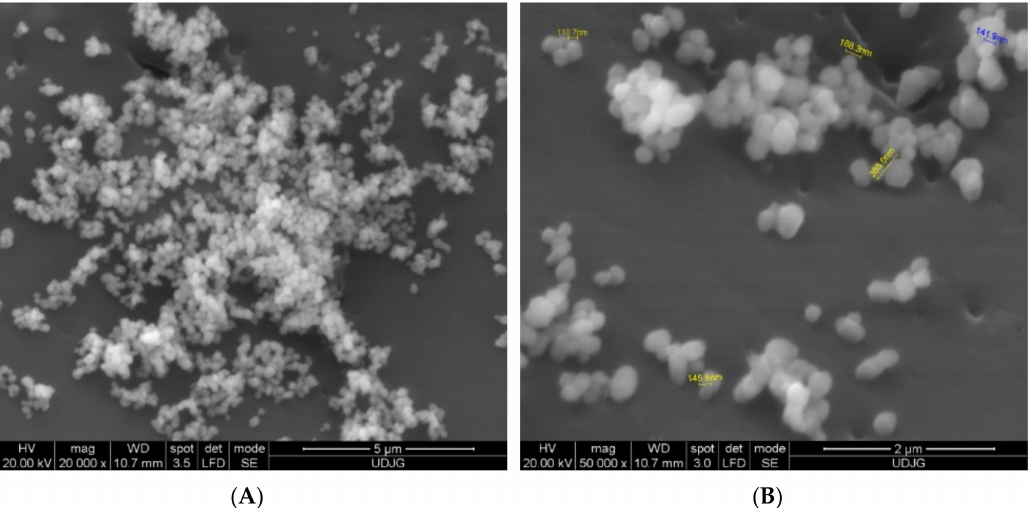
Figure 2. The SEM images of the microencapsulated anthocyanins from sweet cherries skins. ( A ) Direct view of aggregates; ( B ) Measurement of aggregates dimensions. (A—magnification × 20,000, B—magnification ×